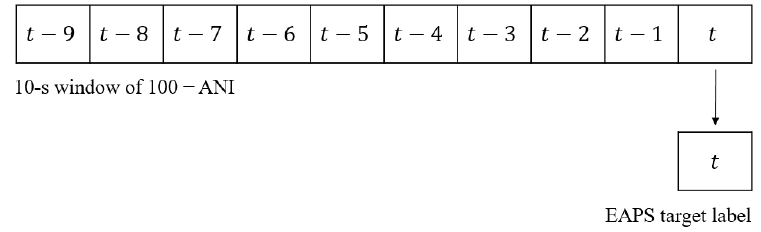
Figure 10. Illustration of the EAPS prediction. Table 1. Data proportion in the holdout method.